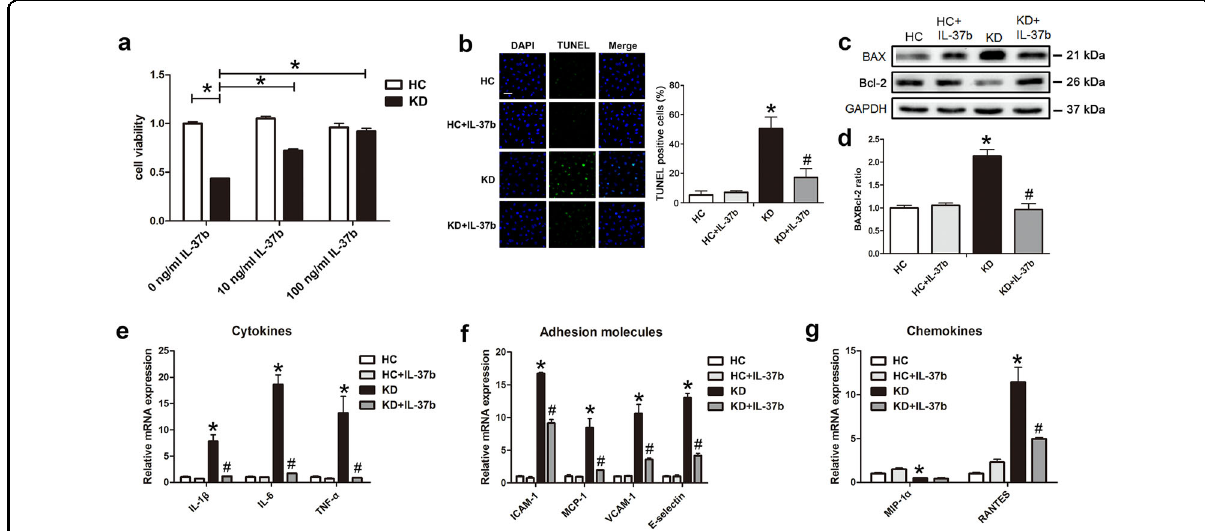
Fig. 3 IL-37b alleviated KD-treated endothelial cell apoptosis and in fl ammation. a CCK8 assay was used to evaluate cell viability ( n = 6). Signi fi cance: * P < 0.05. b DNA fragmentation was analyzed using TUNEL staining ( n = 3). c Protein expression of BAX and Bcl-2 was determined by western blot analysis. d Quantitative analysis of BAX/Bcl-2 ratio was conducted. Data are presented as mean ± SD ( n = 3). e , f The expression levels of cytokines, adhesion molecules, and chemokines were examined in KD-treated ECs after IL-37b treatment ( n = 3). * P < 0.05 vs. the HC group, and # P < 0.05 vs. the KD group. At least three experiments were performed for each